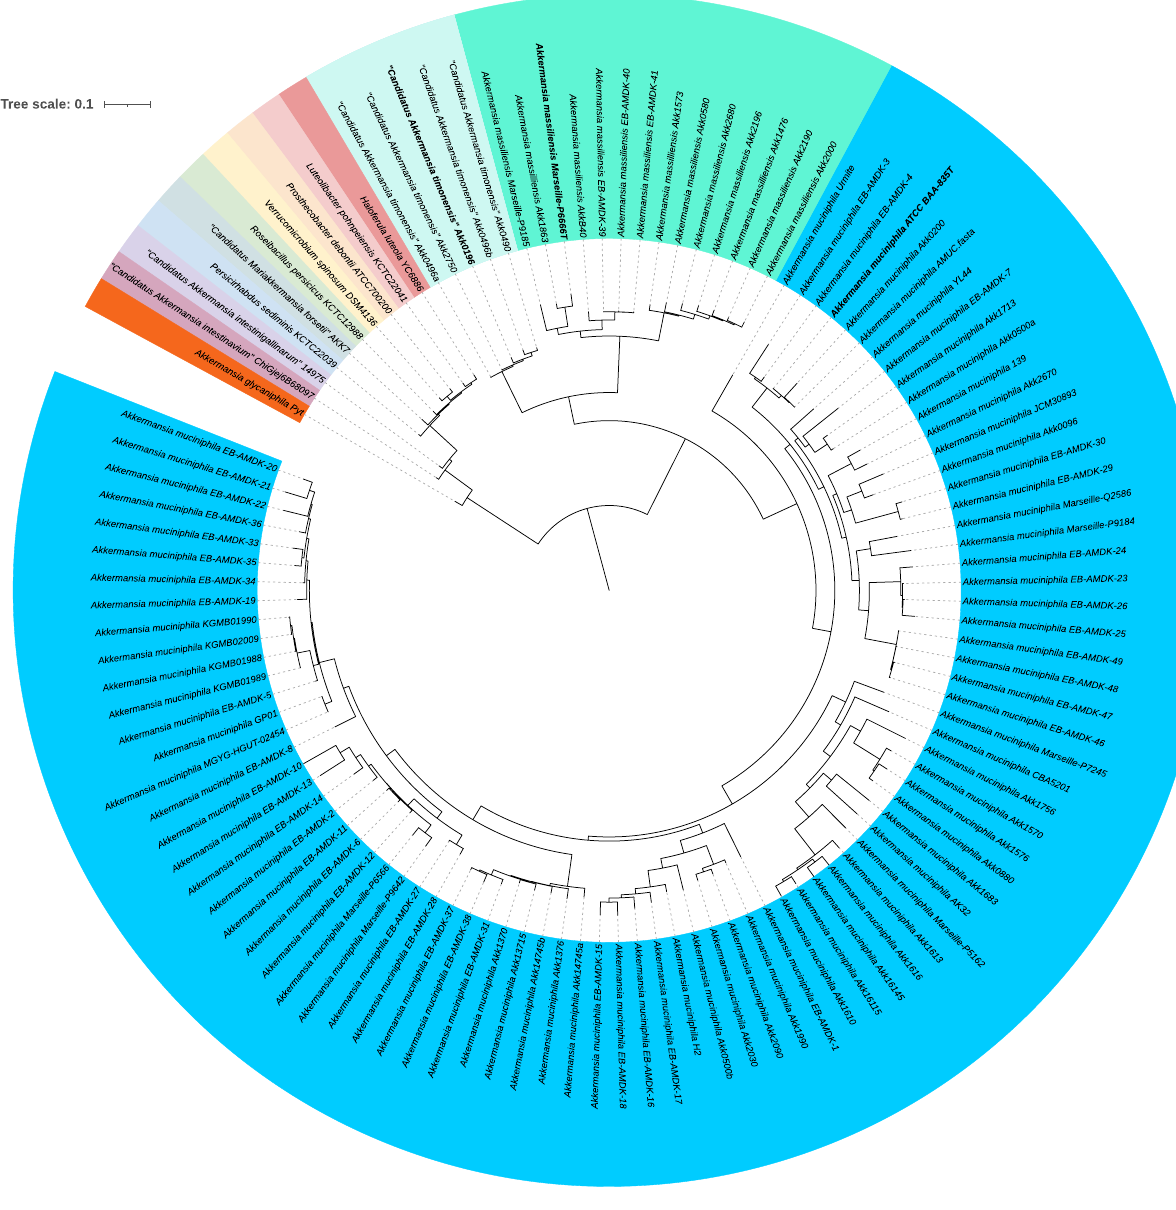
Figure 4. Core genome-based phylogenetic tree highlighting the position of Akkermansia muciniphila strain ATCC BAA-835 T (Cluster I), Akkermansia massiliensis strain Marseille-P6666 (Cluster II), “ Candidatus Akkermansia timonensis” strain Akk0196 (Cluster III), relative to other type strains within the genus Akkermansia and other members of the family Verrucomicrobiaceae . Sequence alignment was performed using MUGSY and a phylogenetic tree was obtained using the maximum-likelihood method. Numbers at the nodes are bootstrap values (≥ 70%) obtained by repeating the analysis 1,000 times. The scale bar indicates a 10% nucleotide sequence